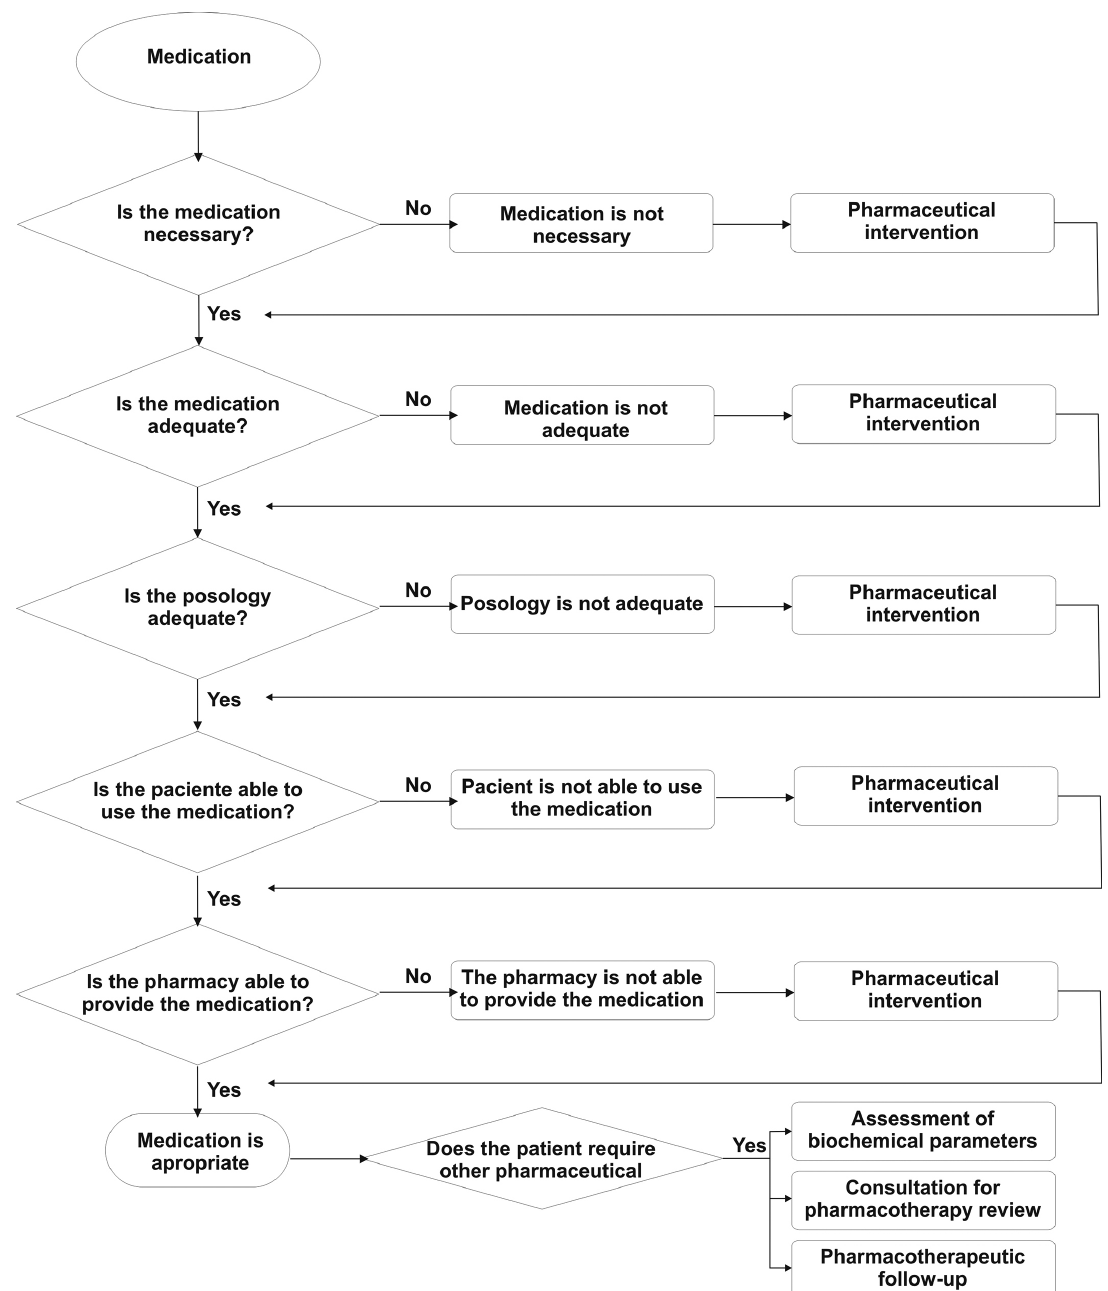
FIGURE 2 - Flowchart of the assessment of pharmacotherapy at the Campus Pharmacy of the Federal University of Goias. Adapted from: Iglésias-Ferreira, Santos,